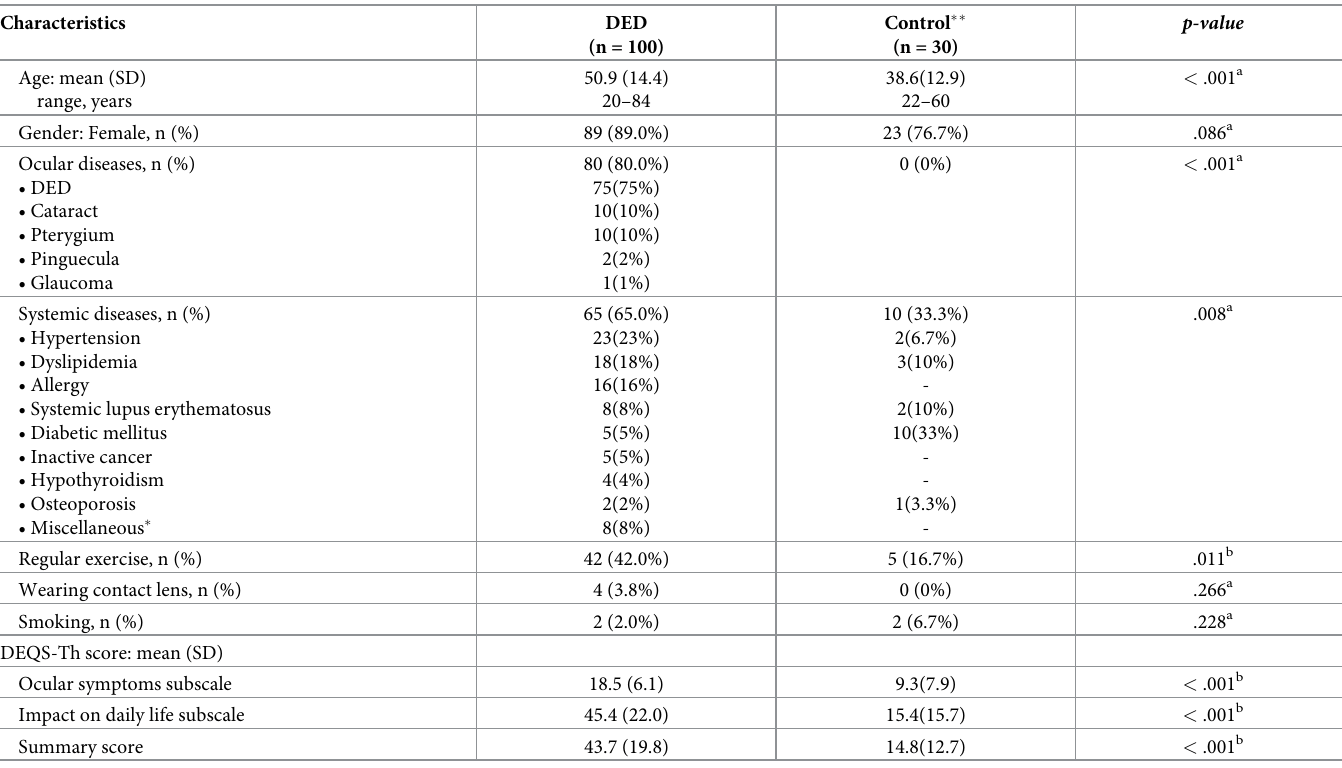
Table 2. Demography and characteristics of DED and non-DED participants.